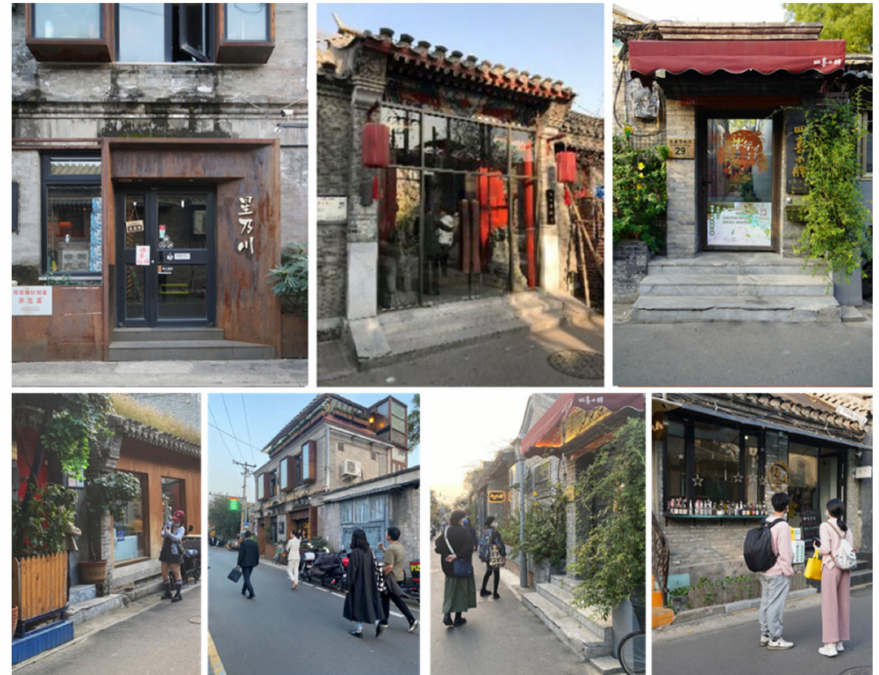
Figure 7. Typical contrast between Chinese and western styles in the building units (or part of the façade) and the resulting tourists’ walking-stopping behaviors captured in Wudaoying